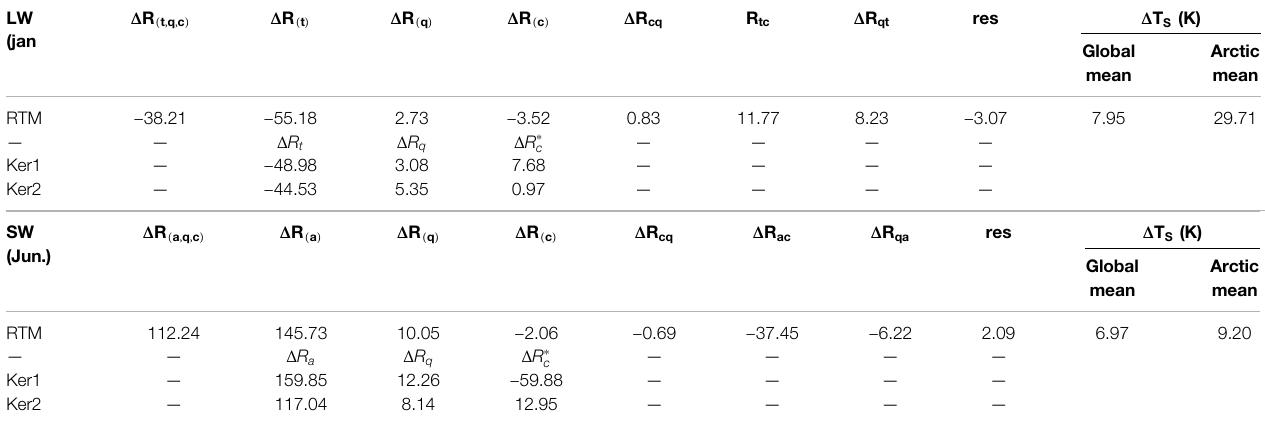
TABLE 1 | Arctic mean all-sky feedbacks in the 4xCO2 experiment for the two selected months. Units: W m-2. Area-weighted averages are taken for the region 70 – 90 ° N. Two sets ofradiative kernelshave been used to measure the univariate linearfeedbacks:Ker1 is computed from the GCM instantaneous pro fi les in this workand thus is of no kernel bias; Ker2 is the kernel computed by Huang et al. (2017) from the ERA-interim reanalysis pro fi les, which leads to biases in diagnosed univariate feedback as explained by Eq. 8 . LW